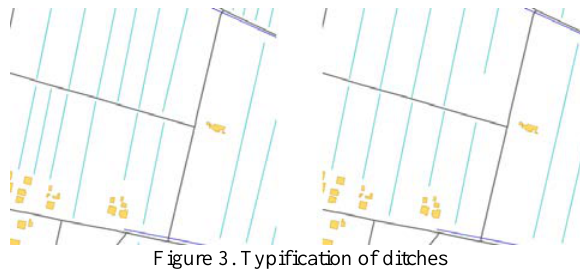
Figure 3. Typification of ditches